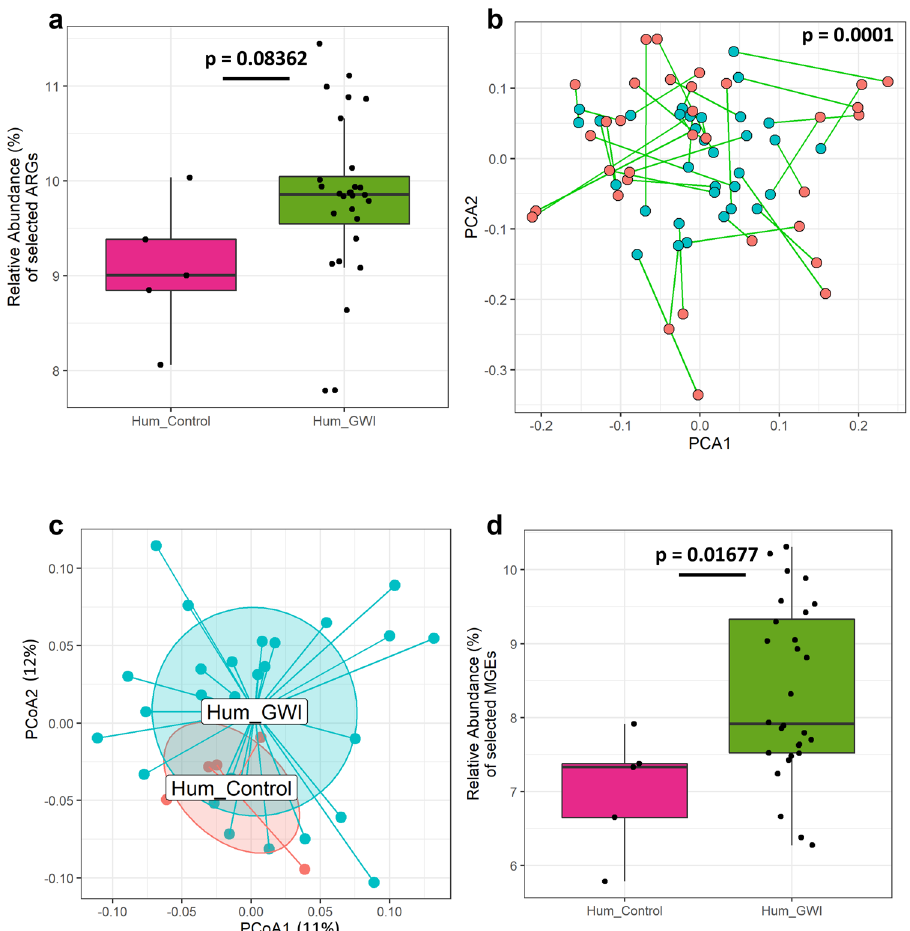
Fig. 3 Distribution of ARGs and MGEs in GWI Veteran groups. a Box plot showing relative abundance (%) of ARGs in Hum_Control (Veteran group without GWI symptom, n = 5 biologically independent samples) and Hum_GWI (Veteran group with GWI symptom, n = 28 biologically independent samples). Median values of 9.0% in Hum_Control and 9.86% in Hum_GWI are indicated by solid black lines. b Procrustes rotation analysis comparing resistome (blue) and microbiome (red) changes using PCA ordinations, ( X -axis: PCA1, Y -axis: PCA2, PROTEST, M 2 = 0.6665, p = 0.0001). c PCoA of Bray-Curtis dissimilarity between ARGs and Taxa. Principal coordinate axes PCoA1(12.7%) and PCoA2 (11.5%) account for 24.2% of detected variance. d Box plot showing relative abundance (%) of selected MGEs in Hum_Control and Hum_GWI. Boxes in the box plots indicate interquartile range. Error bars in the box plots extend to the most extreme values within 1.5 times the interquartile range. Outlier data points are represented by black dots drawn outside of the box plot. p -values were determined using PROTEST or Welch ’ s t -test where p < 0.05 was considered statistically signi fi